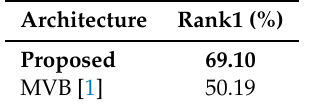
Table 3. Performance comparison with the solution proposed in [1].